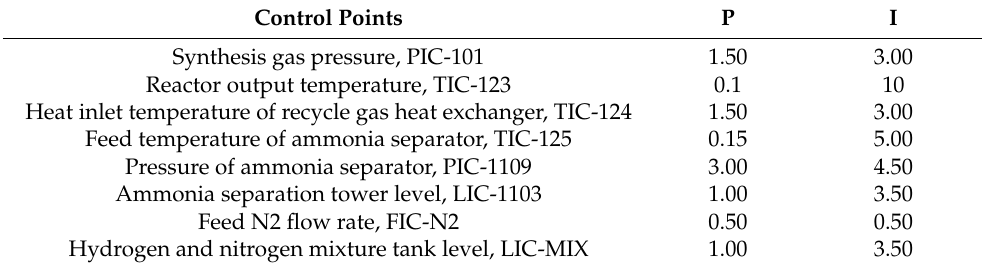
Table 7. Optimized PID parameters.